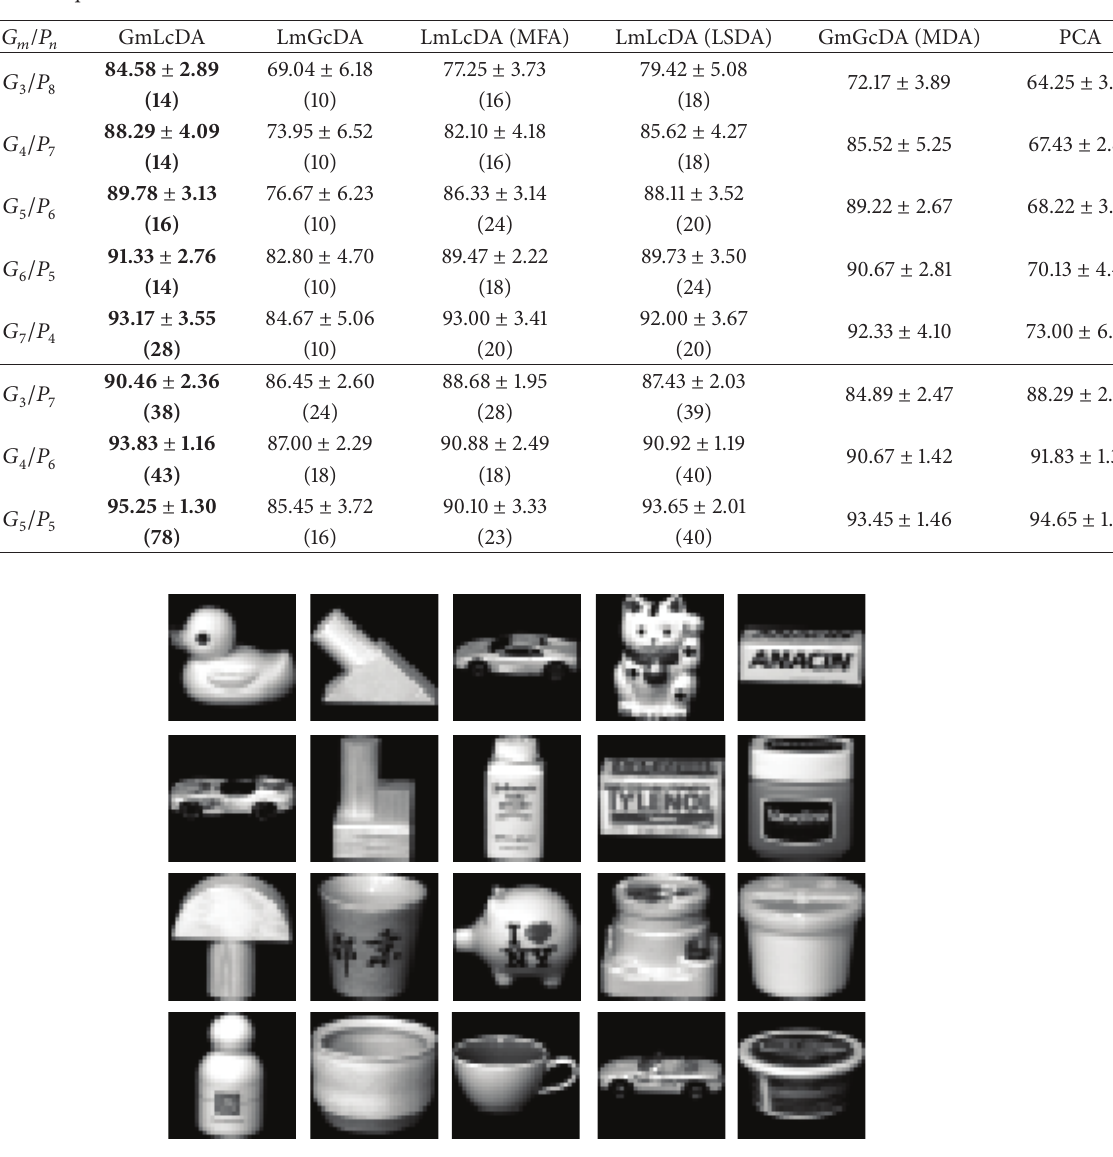
Table 2: Accuracy% ± standard deviation (optimal reduced dimensions), where the reduced highest dimension of MDA is number of class subtract one, here equals one.